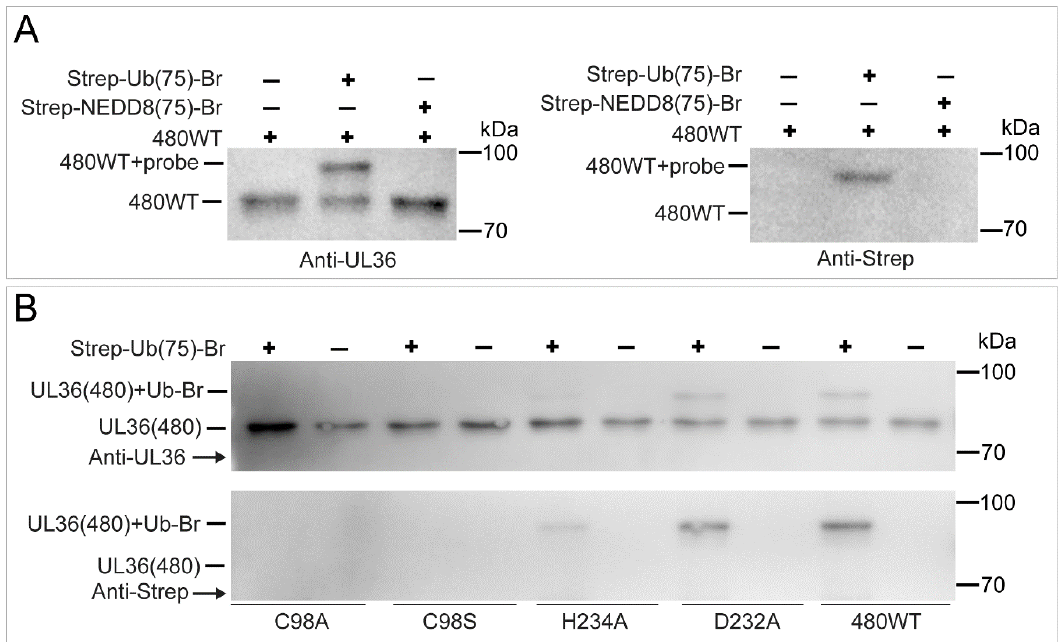
Figure 7. Identification of UL36-DUBs binding to the Strep-Ub(75)-Br or Strep-NEDD8(75)-Br probe. ( A ) Identification of the products of UL36(480) WT binding to the Strep-Ub(75)-Br and Strep-NEDD8(75)-Br probes by Western blot using anti-UL36 (left panel) or anti-strep (right panel) antibodies; ( B ) Identification of the products of UL36(480) WT and mutants binding to the Strep-Ub(75)-Br probe by Western blot using anti-UL36 (upper panel) or anti-strep (lower panel) antibodies. 480WT, wild type UL36(480); C98S, C98A, D232A, and H234A refer to UL36(480) C98S , UL36(480) C98A , UL36(480) D232A , and UL36(480) H234A mutants, respectively. Probe, Strep-Ub(75)-Br or Strep-NEDD8(75)-Br probe.